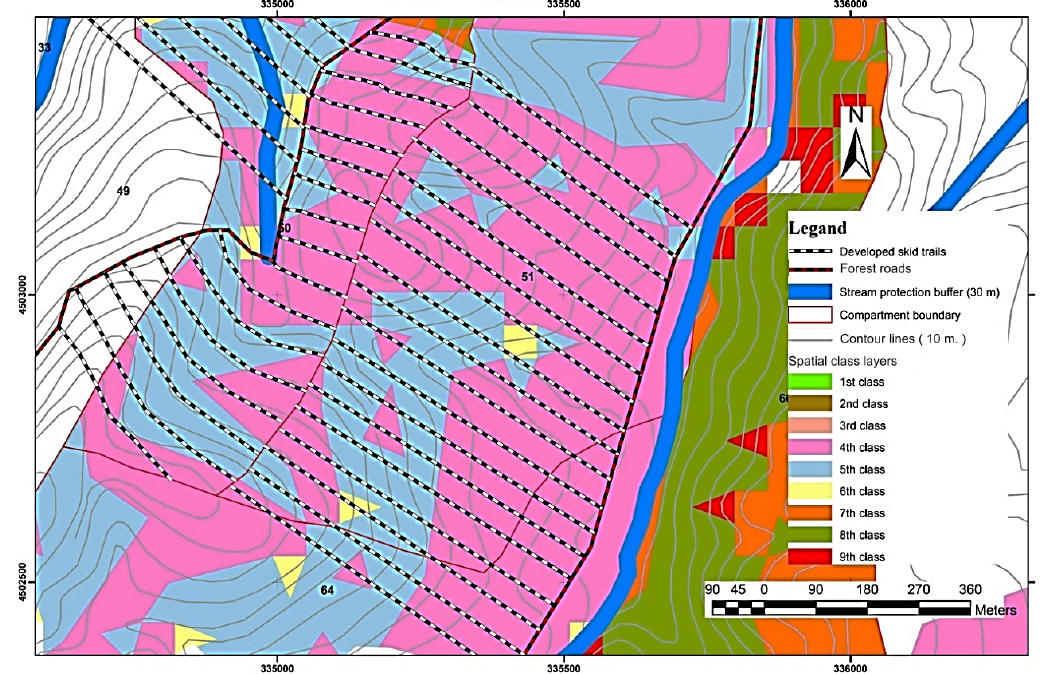
Figure 2. Direct skid trail pattern on the optimum spatial class layer.